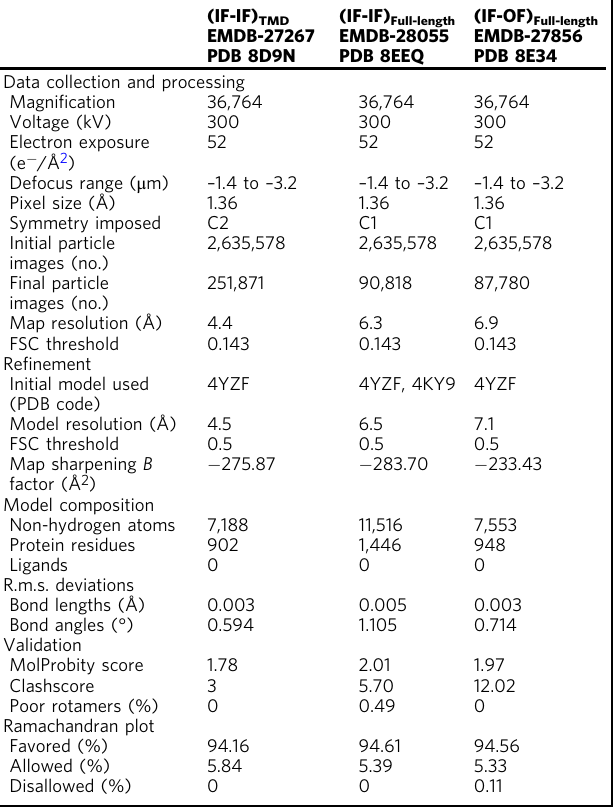
Table 1 Cryo-EM data collection, re fi nement, and validation